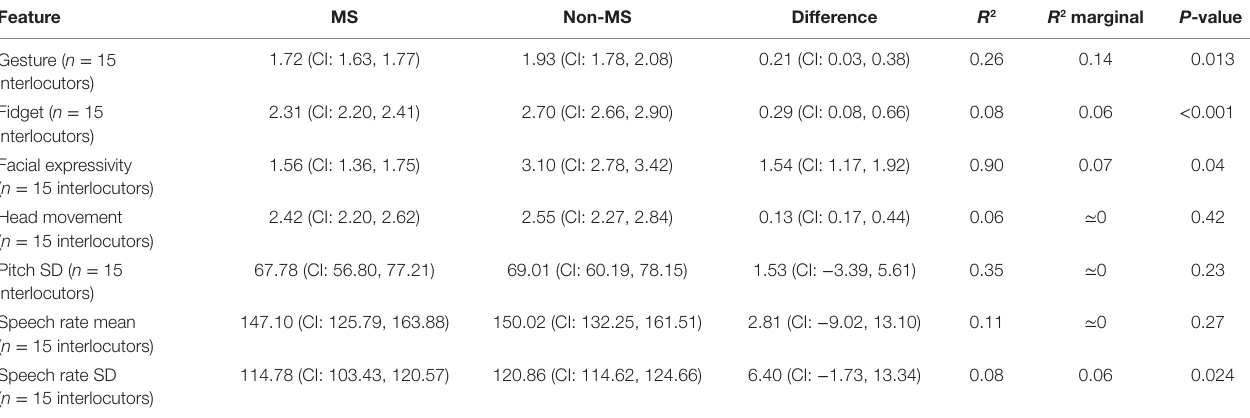
TaBle 3 | Main effect of Ms participants vs. non-Ms participants on individual behaviors.